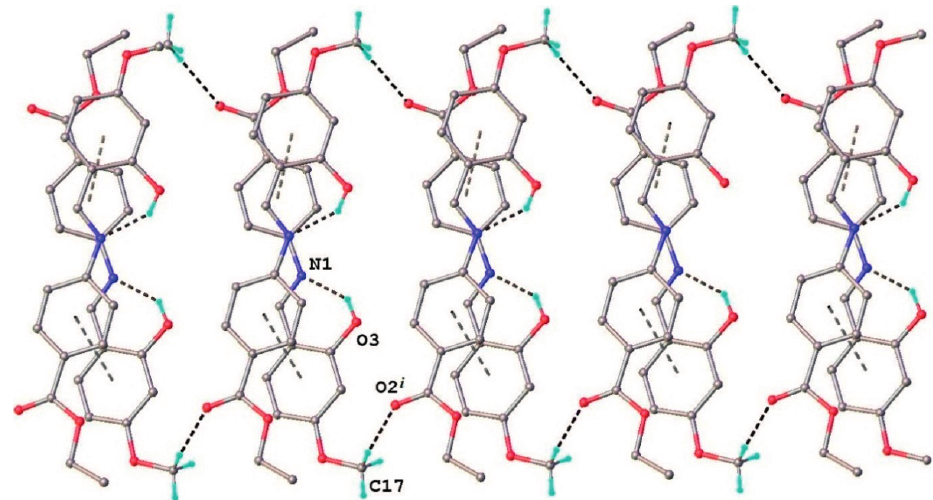
Figure 5. View of the supramolecular ribbon in the crystal structure ( HL)